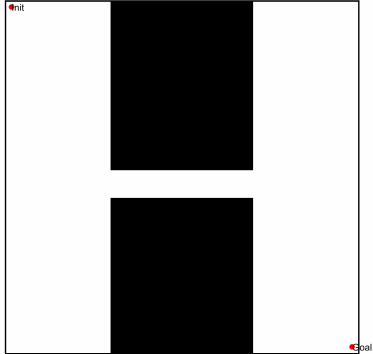
Figure 8. A typical working environment.